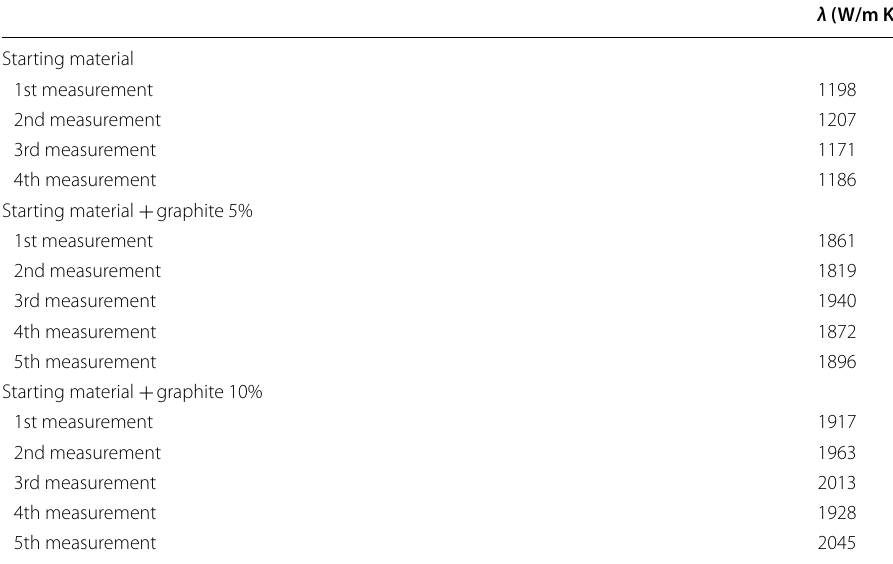
5 and 10% + + λ (W/m K)